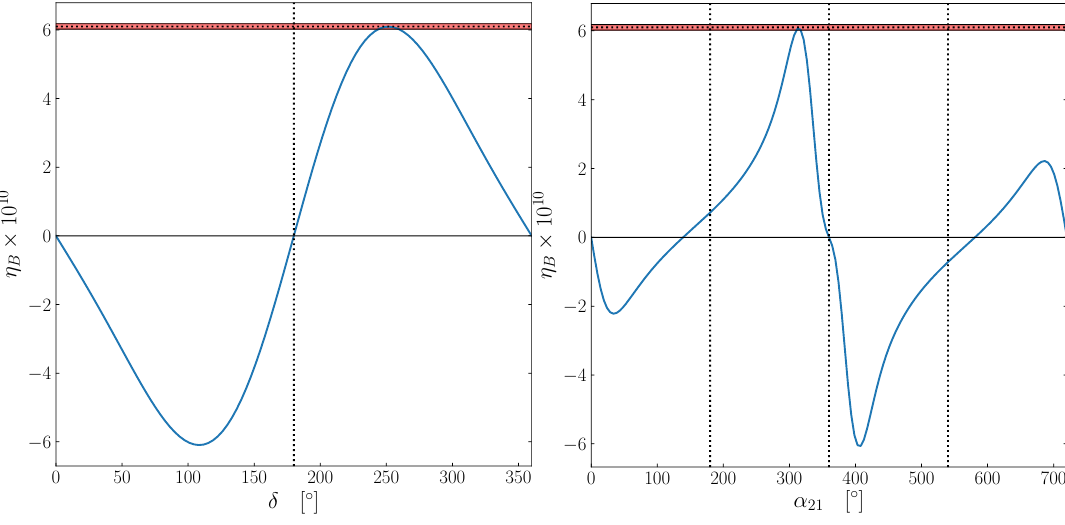
Figure 6 . The same as in (cid:12)gure 5 but for neutrino mass spectrum with inverted ordering. The phase (cid:11) 31 decouples in this scenario and so a (cid:12)gure with the dependence of the baryon asymmetry on (cid:11) 31 is not shown. See text for further